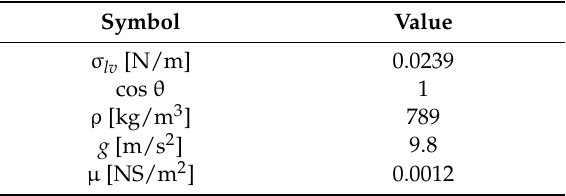
Table 2. Physical properties of EtOH used for capillary rise study at 19 ◦